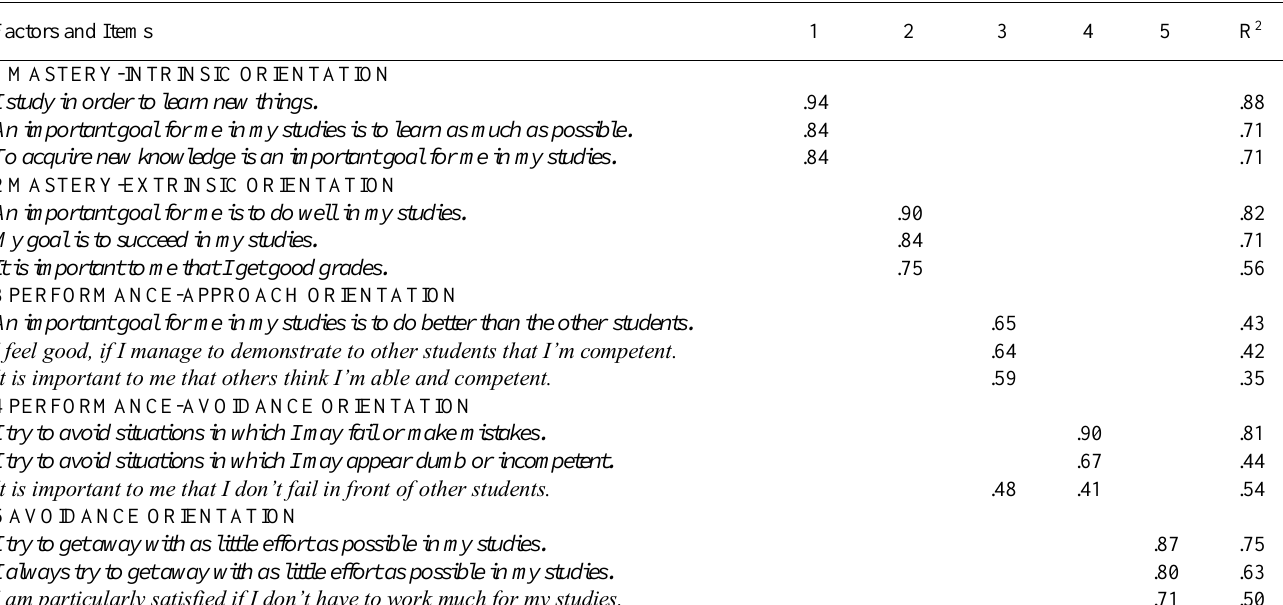
Table 5. Factor Loadings (SEM) of Achievement Goal Orientations, and Explained Variance of Items (Study 2). Factors and